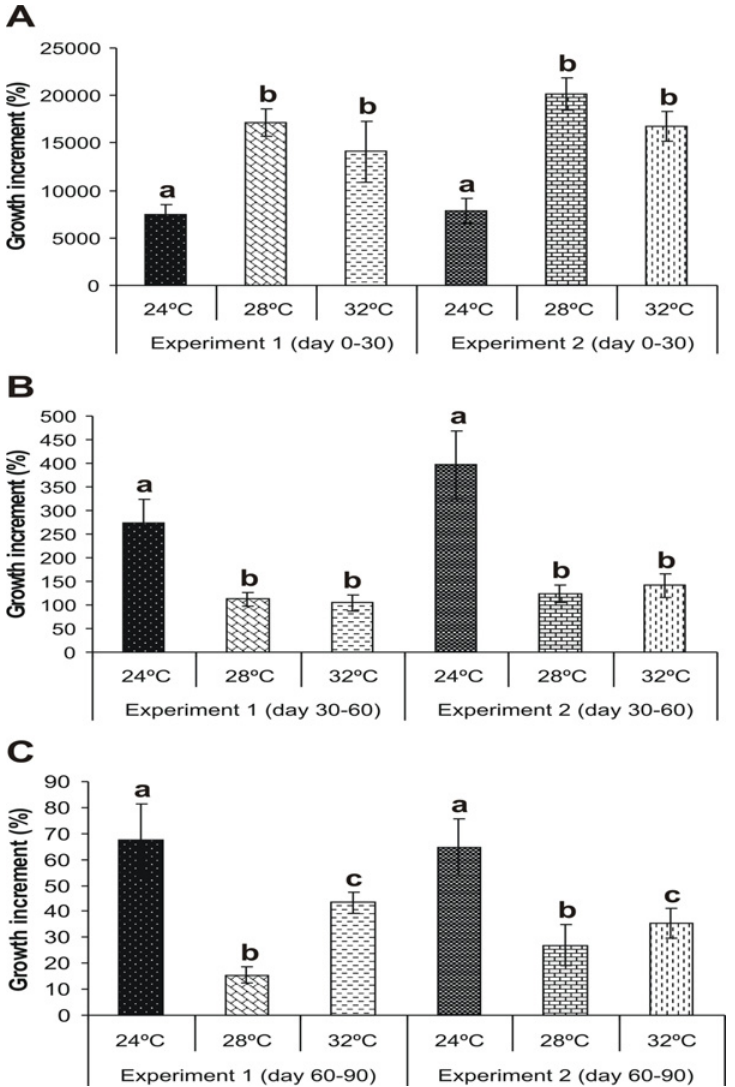
Fig 4. Growth increment (mean ± SE) of shrimps during the Growth period of Experiment 1 and Experiment 2. Neocaridina heteropoda heteropoda juveniles were reared at three different water temperatures (24, 28 or 32°C) over a 90-day period and the growth increment was calculated from day 0 to day 30 (A), from day 30 to day 60 (B), and from day 60 to day 90 (C). Different letters indicate statistically significant differences among treatments for each experiment ( P < 0.05). In both experiments, the growth increment of shrimps maintained at 24°C was lower than that of shrimps maintained at 28 and 32°C at day 30, but this was reversed on subsequent